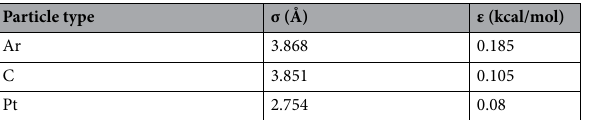
Table 1. The parameters of Lennard–Jones potential function for different particles in MD simulations 20